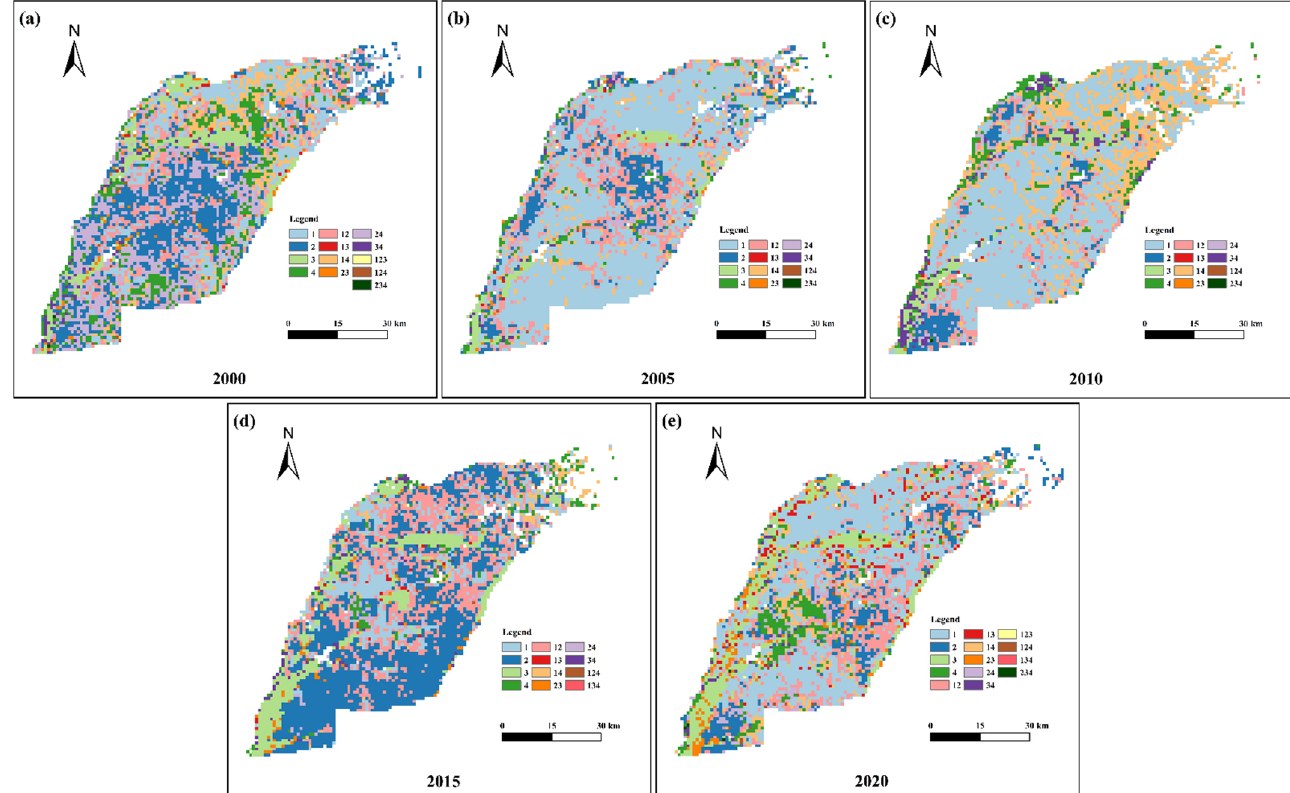
Figure 4. Spatial distribution of CPS based on 900 m × 900 m units in 2000, 2005, 2010, 2015,